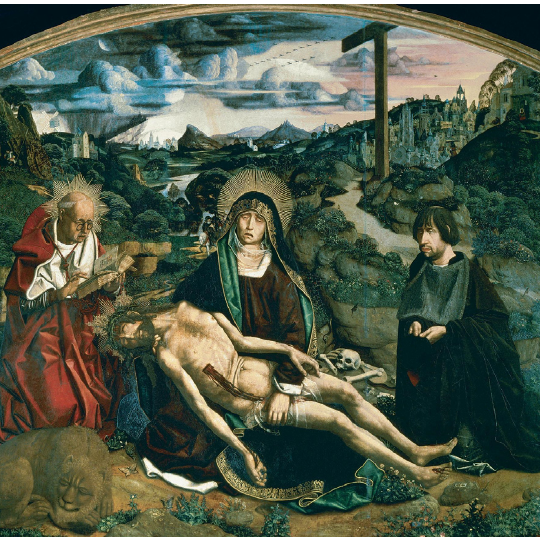
Figure 8. Piety Despl à , Bartolom é Bermejo, 1490, Cathedral of Barcelona. © Cathedral of